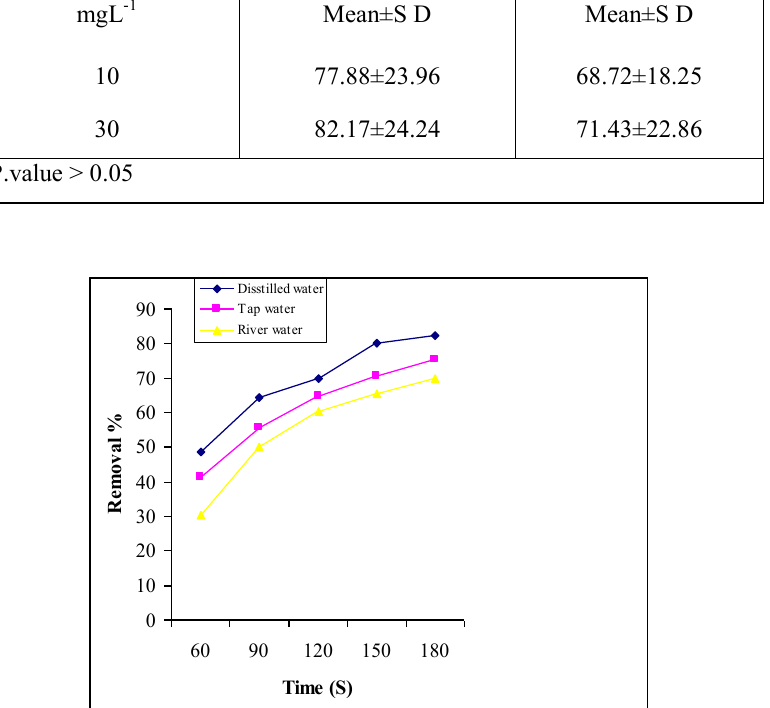
Table 3 . Comparison of decomposition mean percentage pesticides with UV/ H